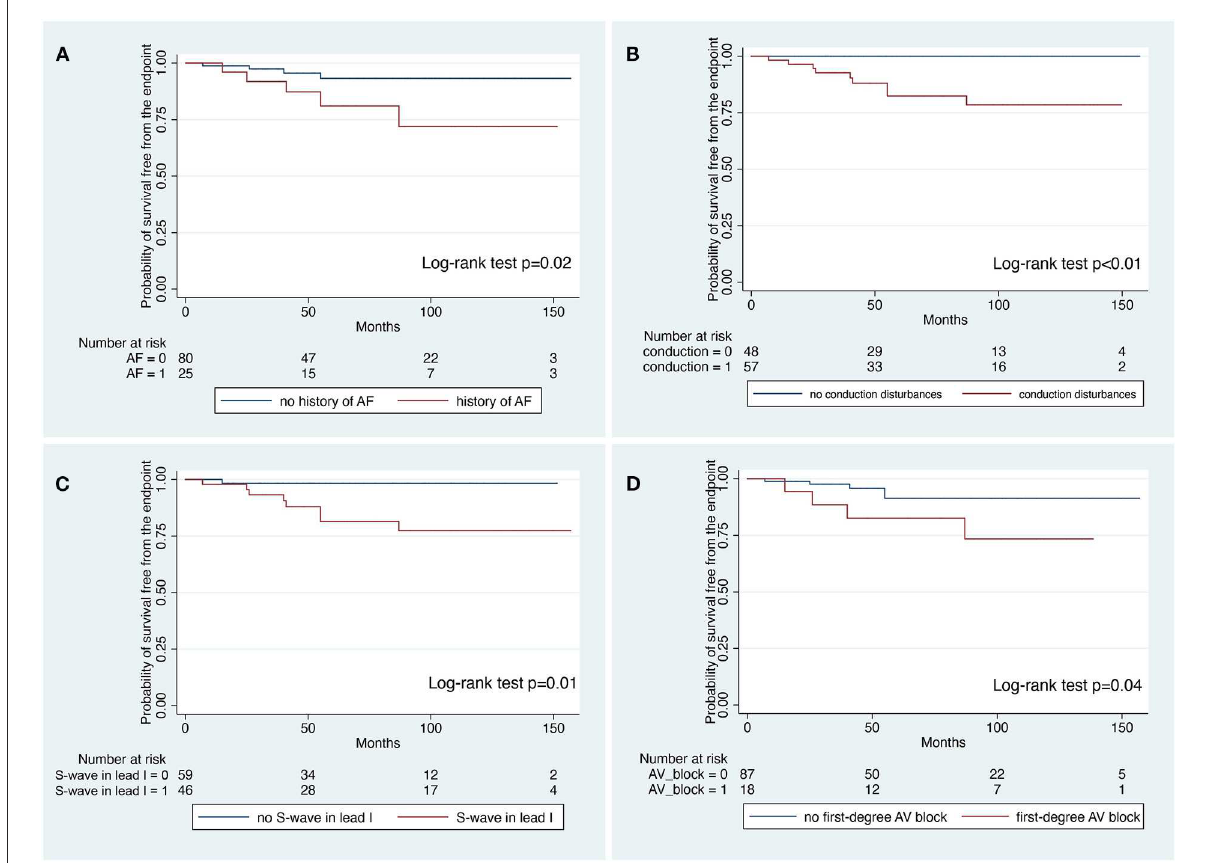
FIGURE2 Kaplan–Meier analysis for survival free from the endpoint according to the presence of history of atrial fibrillation (A) conduction disturbances, (B) S-wave in lead I, (C) and first degree atrio-ventricular block (D)